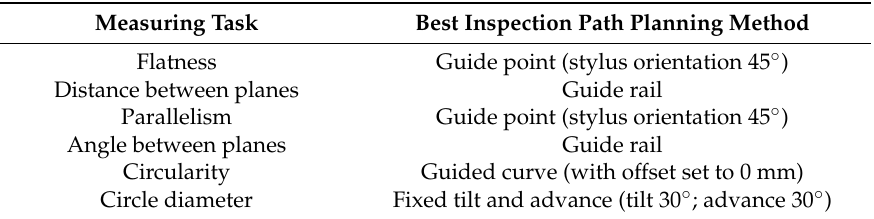
Table 2. The best inspection path planning method to be used for basic measuring